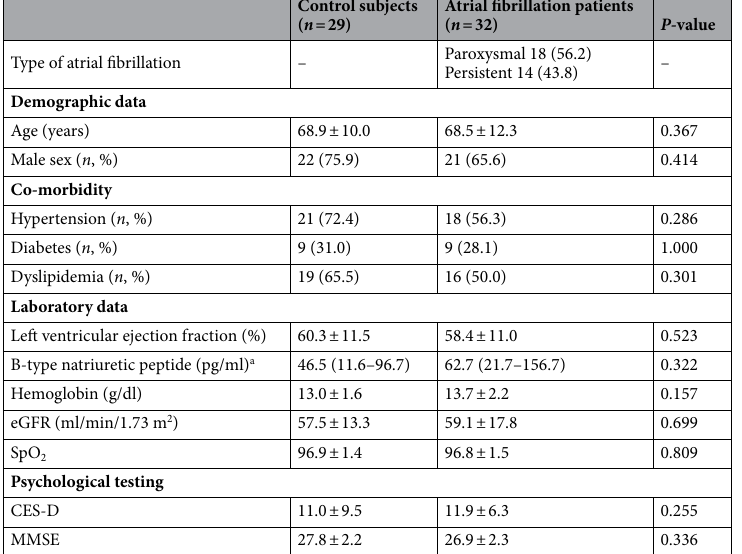
Table 1. Comparisons of clinical features between the control subjects and atrial fibrillation patients. eGFR, estimated glomerular filtration rate; SpO 2, percutaneous oxygen saturation; CES-D, the Center for Epidemiologic Studies Depression Scale; MMSE, the Mini-Mental State Examination. a Data are presented as median (interquartile